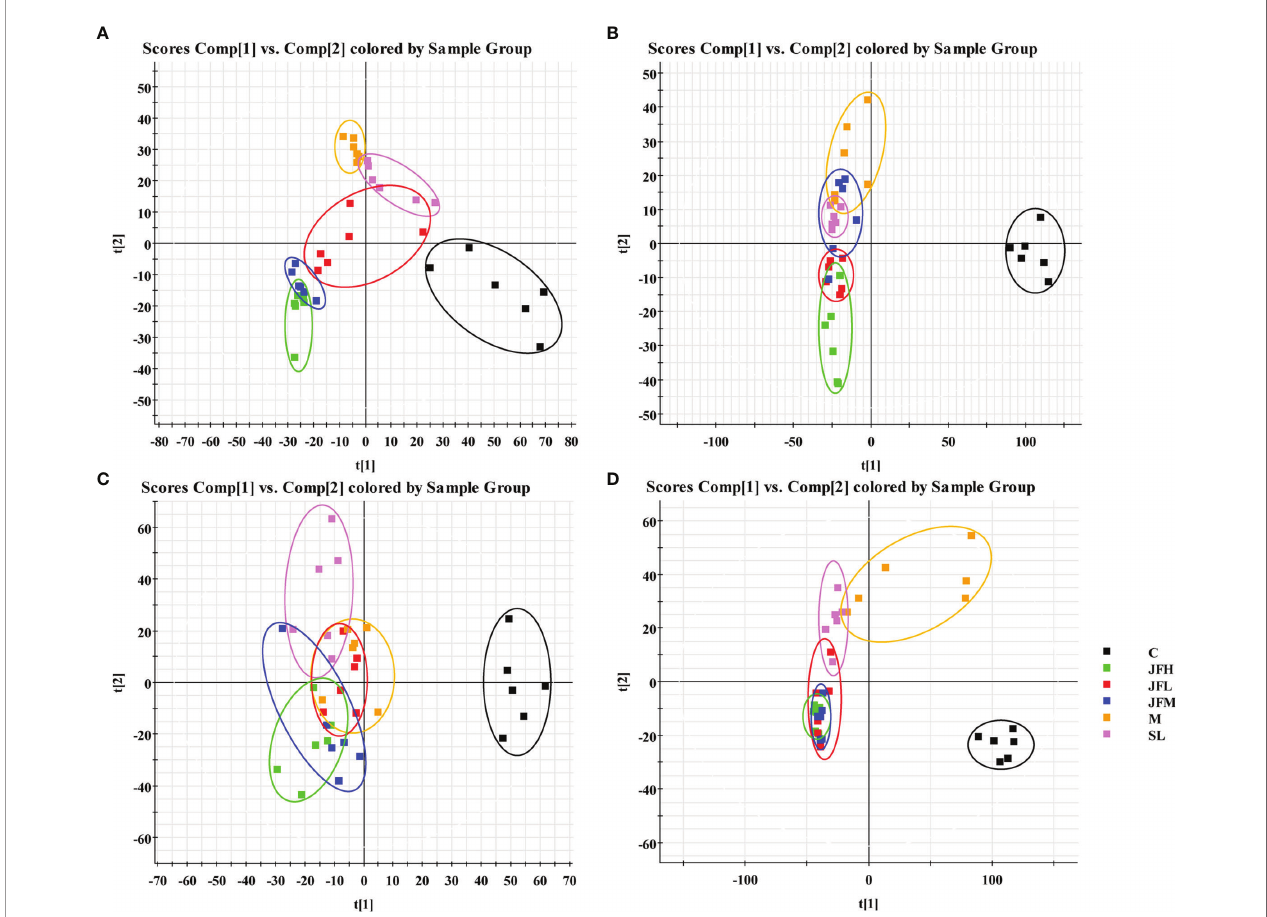
FIGURE 3 | PLS-DA score plots of rat plasma and urine samples classifying the C, M, SL, JFL, JFM and JFH in both positive and negative modes. (A) ESI + mode of plasma; (B) ESI - mode of plasma; (C) ESI + mode of urine; (D) ESI - mode of